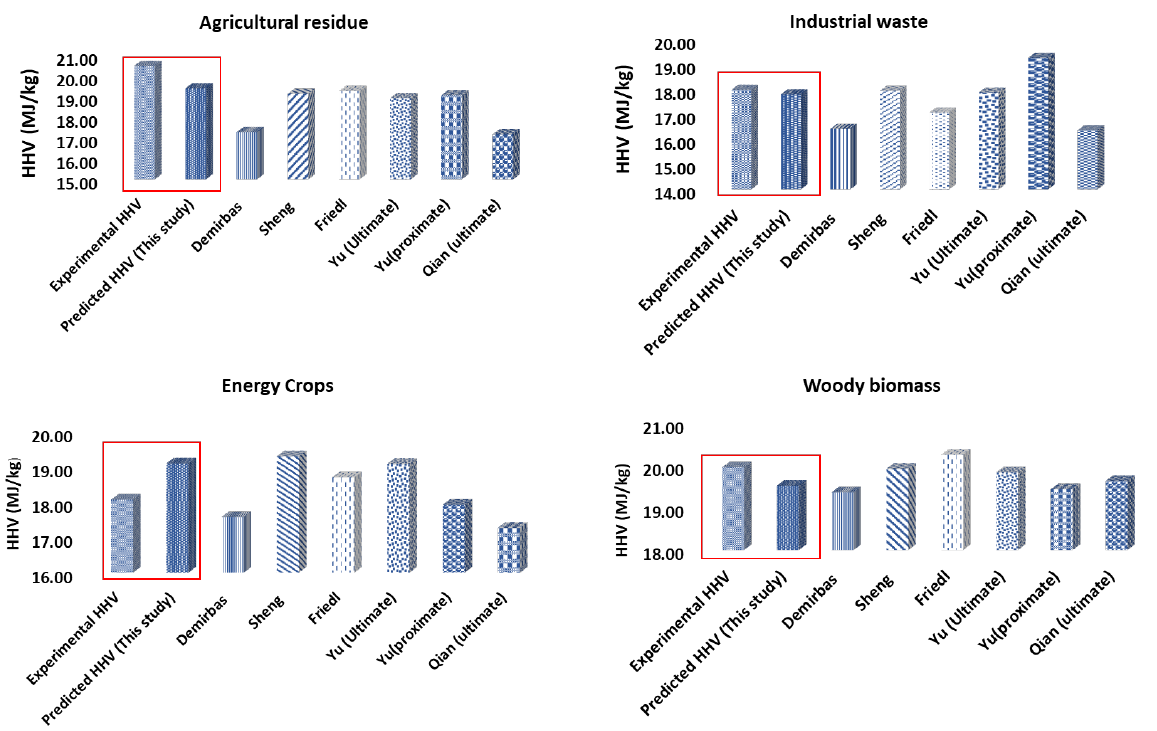
Figure 9. Comparison of the predicted HHV from ML model with empirical models. Note: All the empirical correlations are outlined in Table 1.